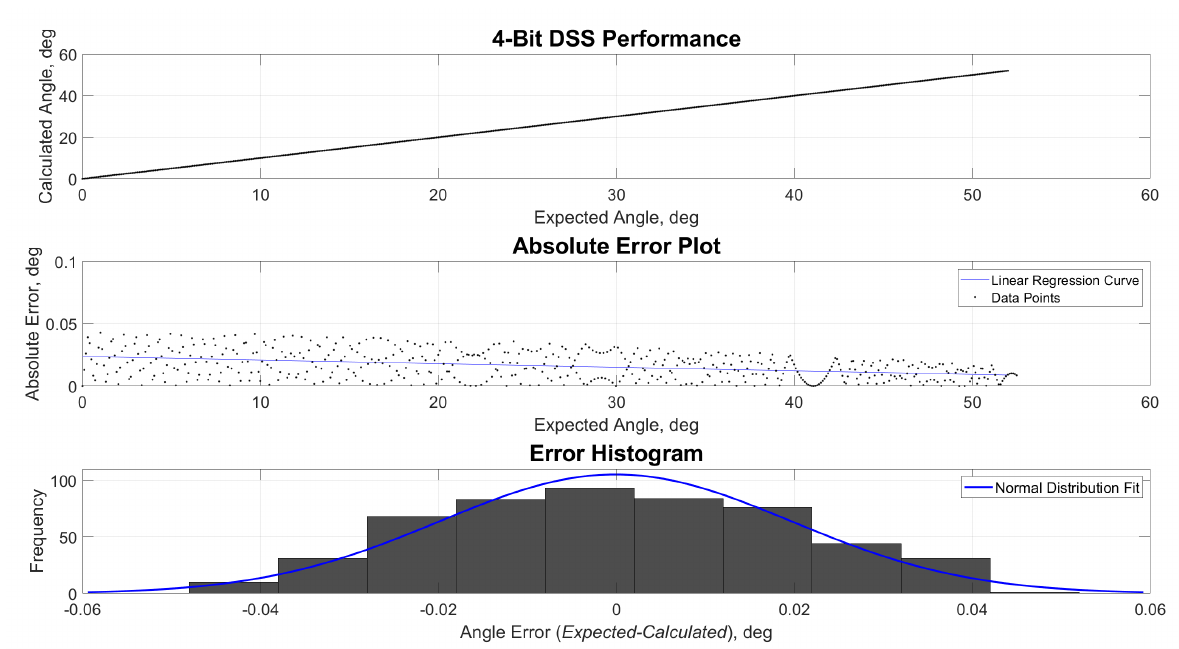
Figure 11. Performance, absolute error and error histogram plots for 4-bit readout mode.